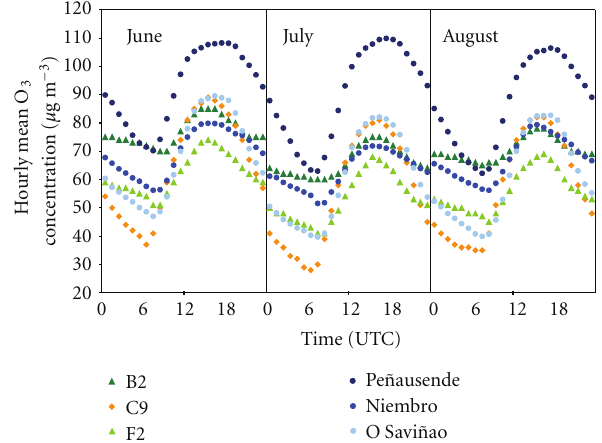
Figure 11: Series of hourly mean ozone concentrations in summer- time (June, July, and August) throughout the 5-year-study period (2002–2006) for each